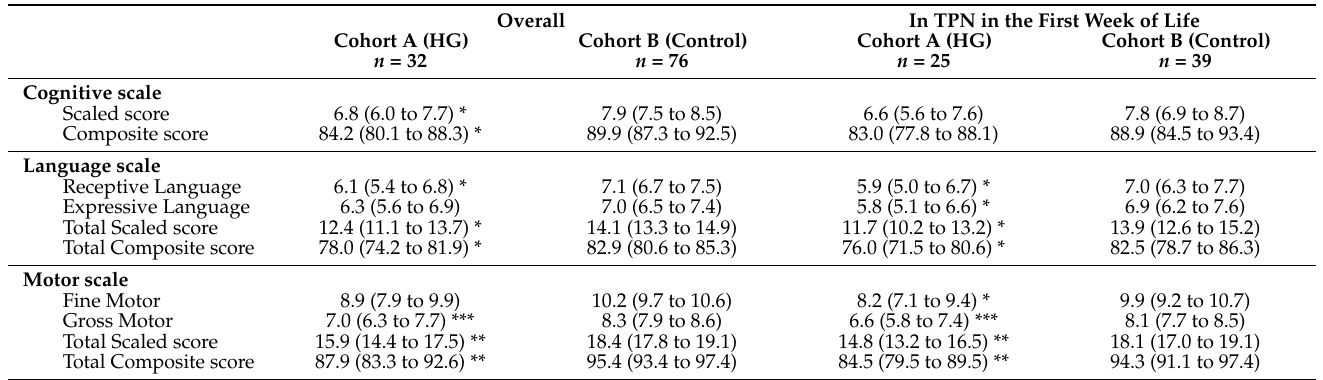
Table 3. Neurodevelopmental outcome at 24 months of life of the study population.